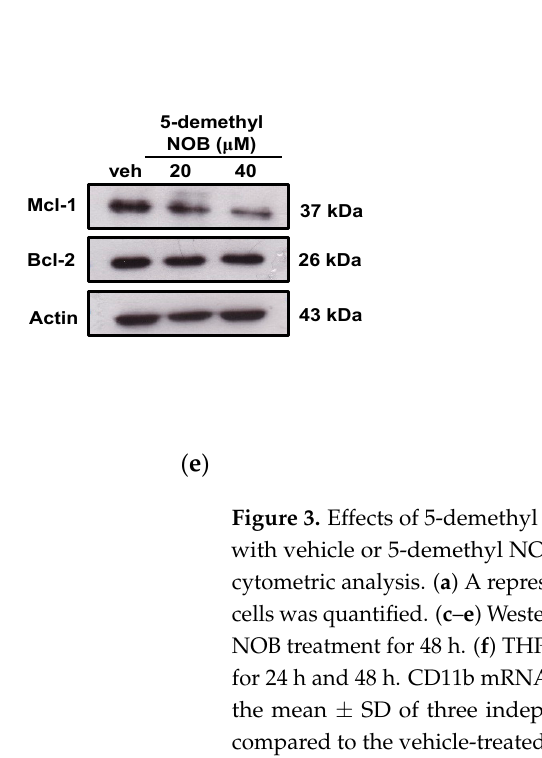
Table 1. The differentially expressed genes (DEGs) of 5-demethyl NOB-treated THP-1 cells. Differentially Expressed Genes